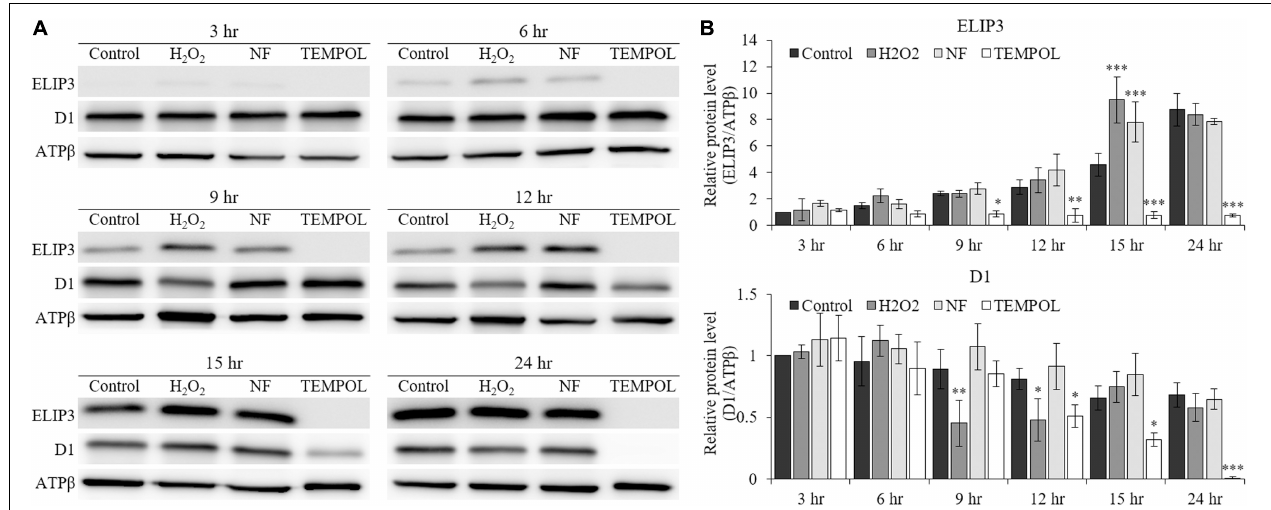
FIGURE 5 | Western blot analysis showing effect of redox reagents on ELIP3 and D1 accumulation over time. (A) The cells were treated with H 2 O 2 (50 µ M), norflurazon (NF, 0.5 µ M) and ROS quencher TEMPOL (20 mM) under low temperature (4 ◦ C, 50 µ mol photons m − 2 s − 1 ). (B) Densitometry of western blots. Data are expressed as mean ± SD (two-way ANOVA vs control with Bonferroni’s multiple comparisons test, n = 3). ATP β was used as a loading control. ∗ P < 0.05, ∗∗ P < 0.01, ∗∗∗ P < 0.001.